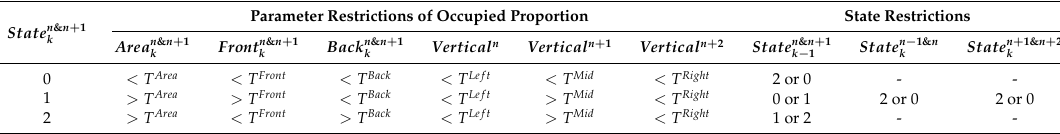
represents the state of ROI n & n + 1 in Frame k